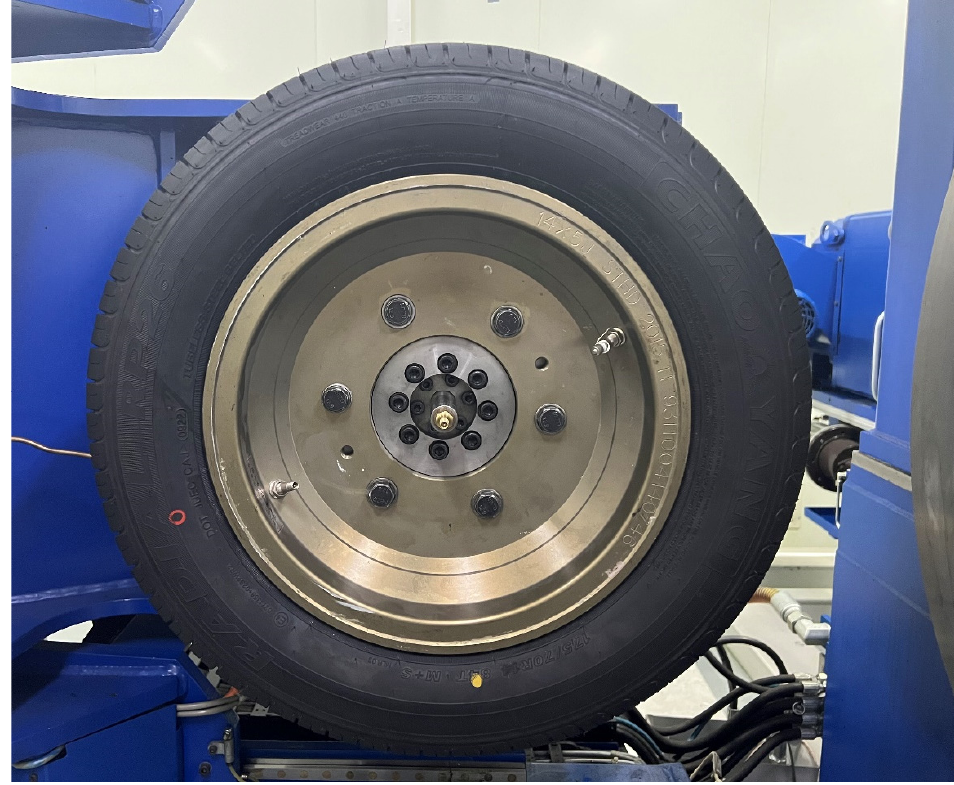
Figure 12. The original pneumatic tire of the Chery eQ1 vehicle (175/70 R14).